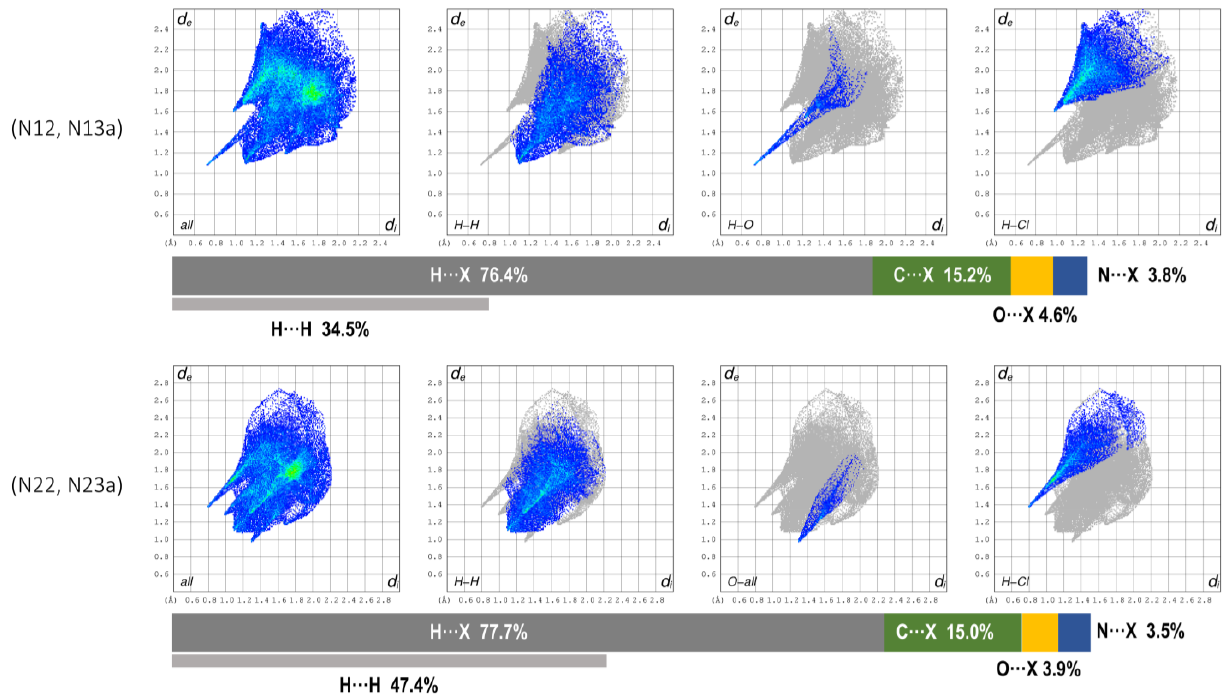
Figure 6. Fingerprint plots of (N12, N13A) and (N22, N23A, major component) [L1] + cations in the crystal structure of 1 showing the specific X i ···X e interactions (where X = Cl, O or H) and their contributions (in %).